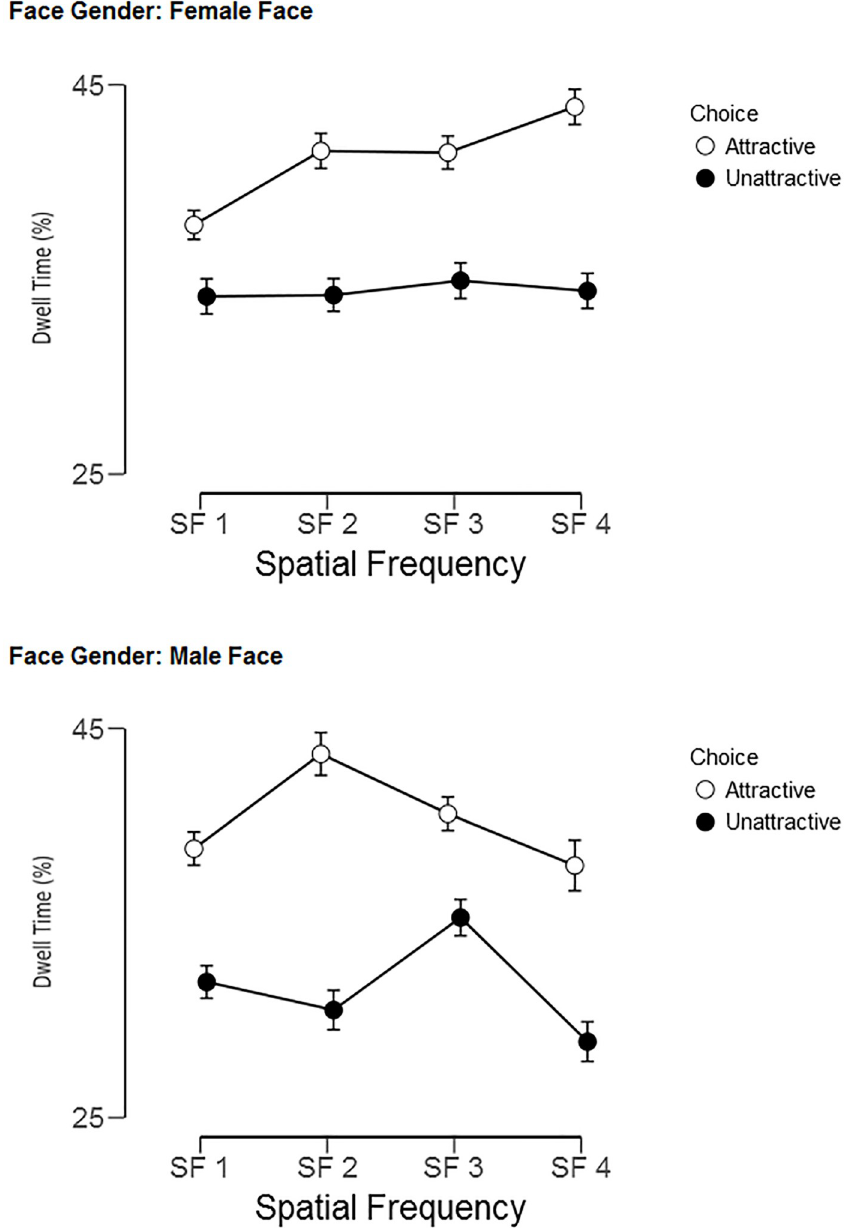
Fig 4. Percentage dwell times of gaze over the attractive versus unattractive face in each pair, split by filtered faces condition, split by Face Gender (top panel = female faces; bottom panel = male faces). Error bars represent the 95% confidence